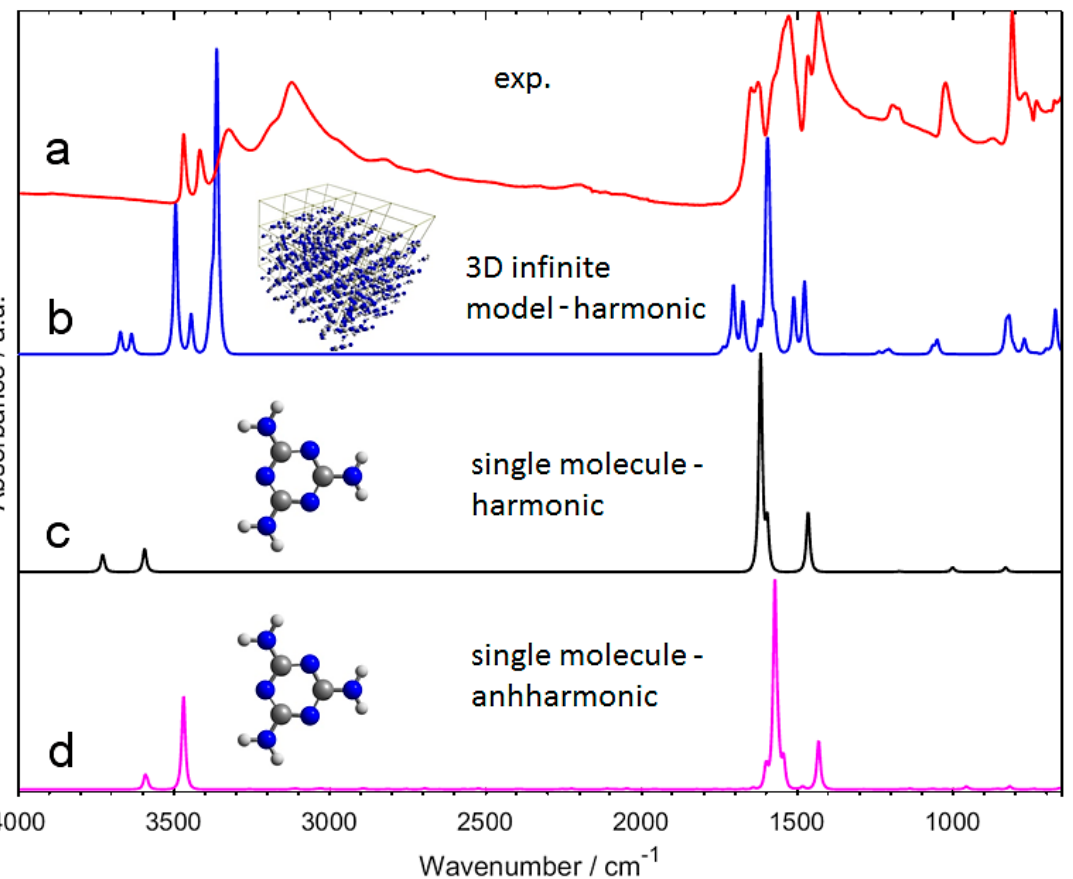
Figure 2. Comparison of the experimental Attenuated Total Reflection IR (ATR-IR) spectrum of polycrystalline melamine ( a ) with the calculated spectra ( b – d ). The spectra were calculated in harmonic (( b ) B3LYP/Gatti for periodic (3D, infinite) model; ( c ) B3LYP-GD3BJ/SNST for single molecule model) and anharmonic (( d ) GVPT2//DFT-B3LYP-GD3BJ/SNST) approximation. For the calculated spectra, no scaling was applied in this figure.